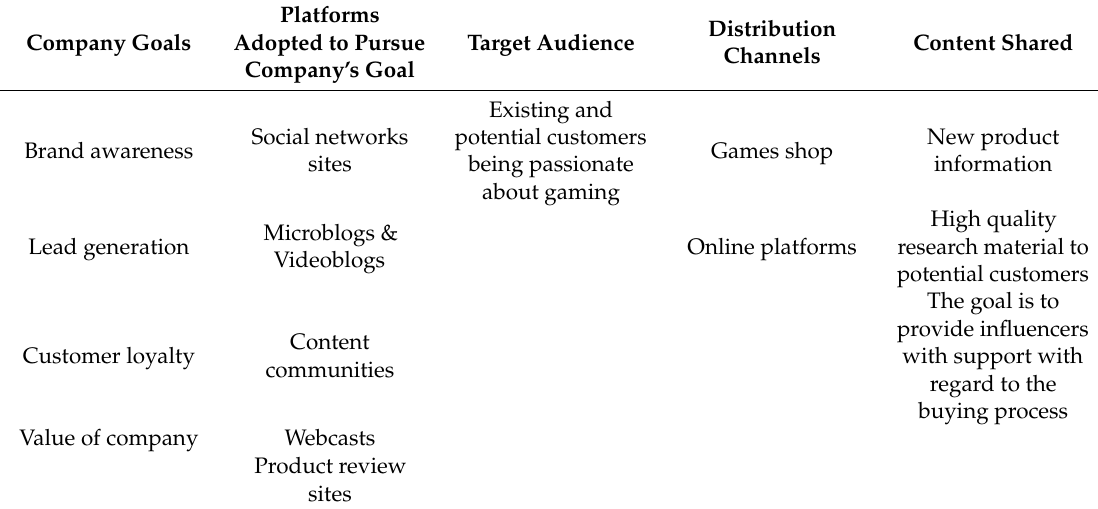
Table 1. Computer game promotion by the creative company—case